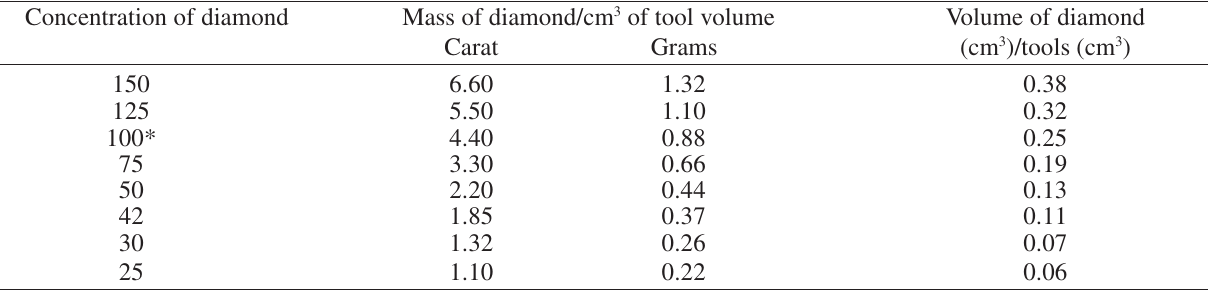
Table 2. Typical concentration versus density of diamonds in cutting